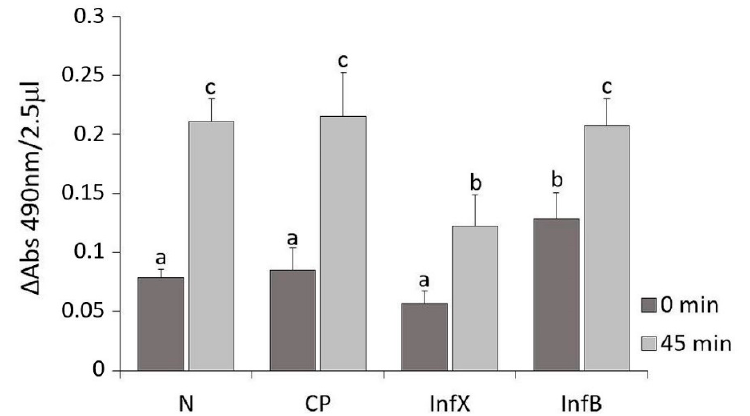
Figure 1. Phenoloxidase relative activity in the hemolymph of D. suzukii shown as the mean ± SD increase of absorbance, recorded at 0 and 45 min ( = 490 nm), in hemolymph samples from naïve (N), control pricked (CP), X. nematophila -infected (InfX) and E. coli / B. subtilis -infected (InfB) larvae. Different letters indicate statistical significance differences between hemolymph samples ( p < 0.05).